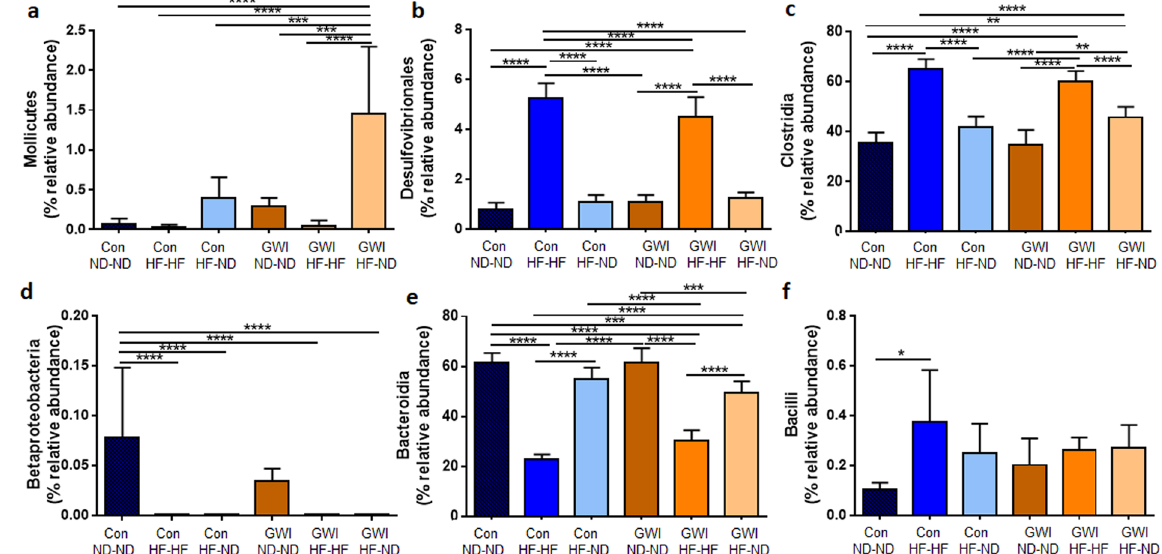
Figure 9. Relative abundance of taxa below the level of phylum in treatment and diet groups. Results are presented as % relative abundance for each taxon. Con = control; GWI = PER + PB; ND = normal diet; HF = high fat diet. Symbols represent significance levels for the indicated post hoc comparisons as p < : * 0.05, ** 0.01, *** 0.001, **** 0.0001.